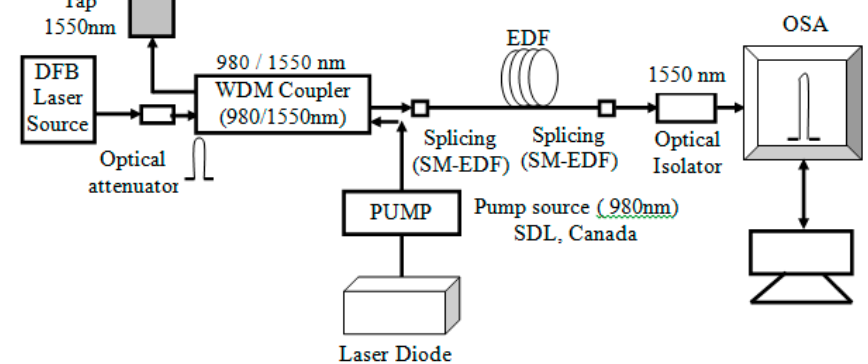
Figure 8. Experimental set-up for optical gain measurement of EDF.